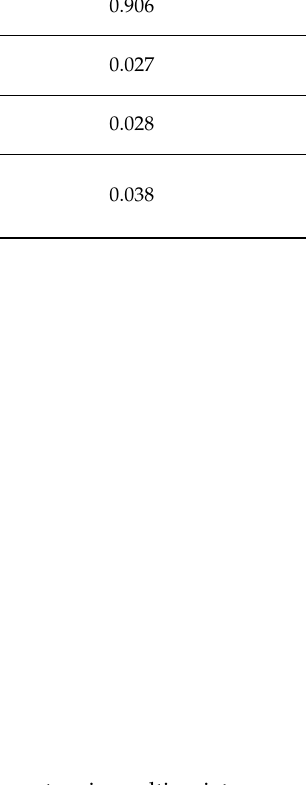
Figure 3. ROC curve for statistically significant parameters in multivariate regression analysis to identify microorganism-containing fluid collections applied to our cohort (n = 86).